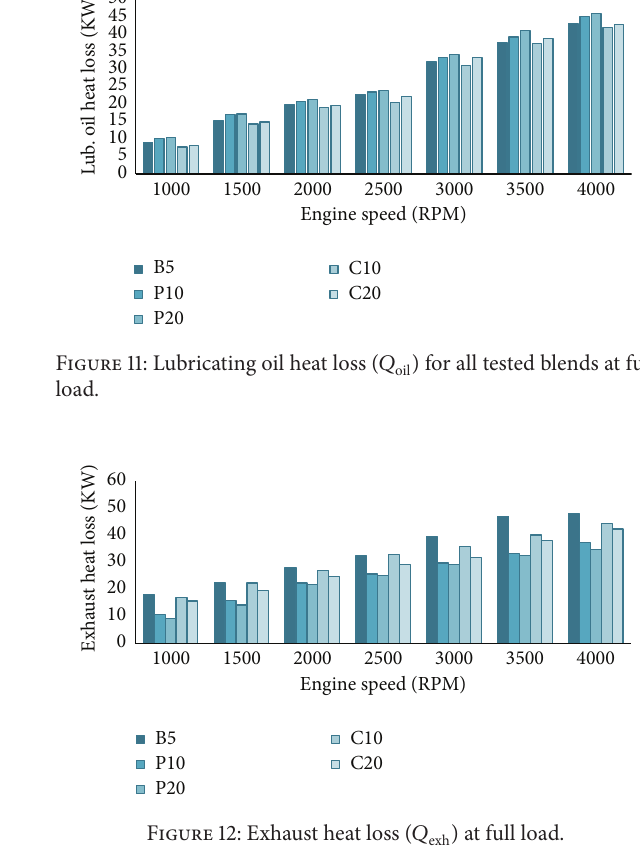
Figure 12: Exhaust heat loss ( 𝑄